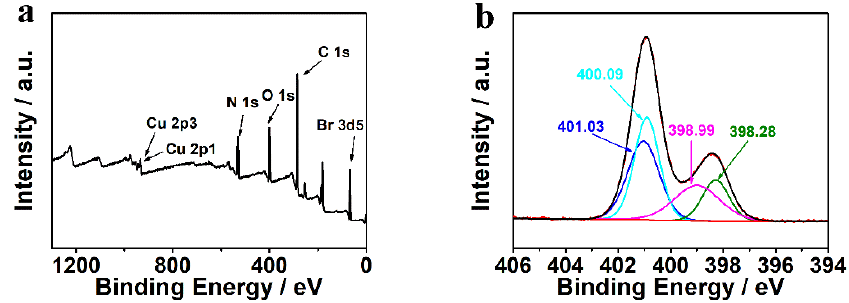
Figure 3. ( a ) Full XPS survey and ( b ) high-resolution N 1s XPS spectrum of Cu 3 (BTC) 2 -PIL-NH 2 . The deconvolution results of N 1s peak are also displayed in ( b ).